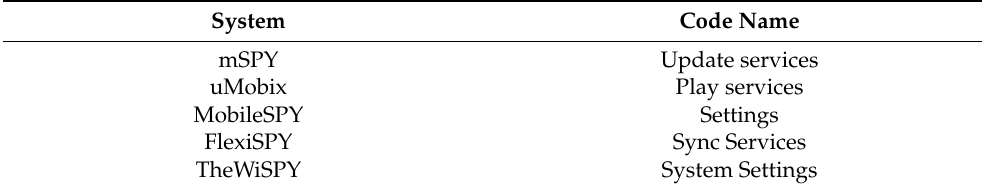
Table 8. Activity list adopted during data collection.